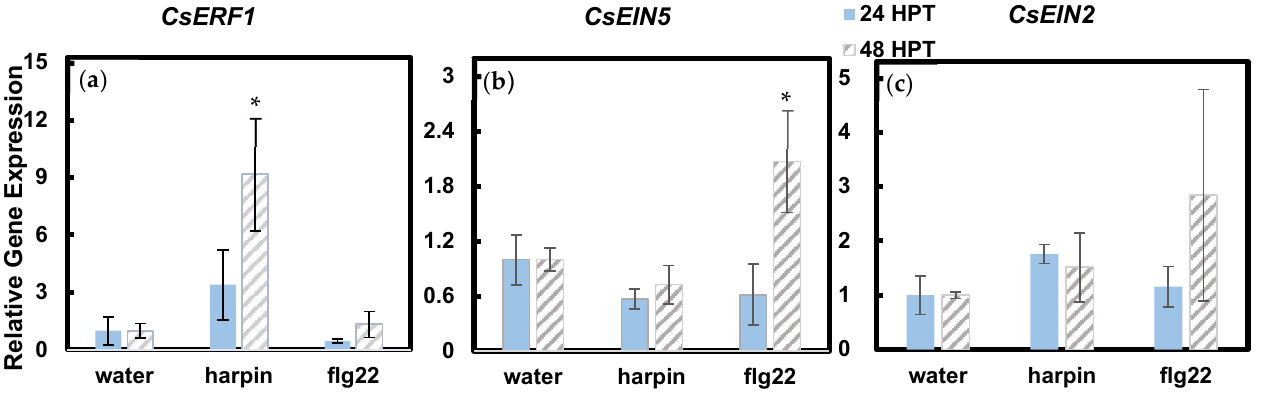
Figure 2. Effects of harpin and flg22 on the expression of ethylene responsive genes, CsERF1 ( a ), CsEIN5 ( b ), and CsEIN2 ( c ), in cannabis seedlings. Cannabis seedings were submerged in water, harpin, or flg22 solutions for 24 h, then incubated on plates for 24 or 48 h. Statistically significant difference in comparison to water control was determined using Student t -test. * indicates p ≤ 0.05.